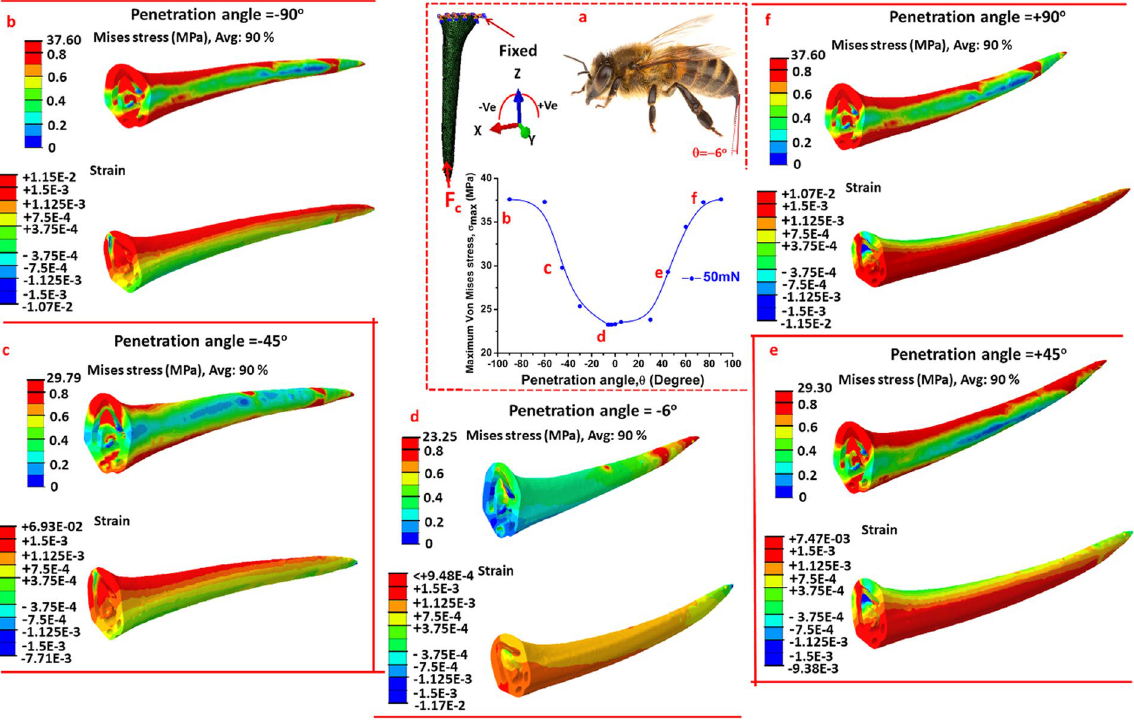
Figure 8. ( a ) Variation of maximum von Mises stress with the angle of applied concentric compressive force (F c ) under cantilevered condition of honeybee stinger, ( b ) Stress and strain distribution at angle − 90°, ( c ) Stress and strain distribution at angle − 45°, ( d ) Stress and strain distribution at angle + 10°, ( e ) Stress and strain distribution at penetration angle + 45°, and ( f ) Stress and strain distribution at + 90°. Honeybee finally adopts the angle of about − 6° to insert its stinger into objects as the maximum von Mises stress and strain become minimum in that angle.